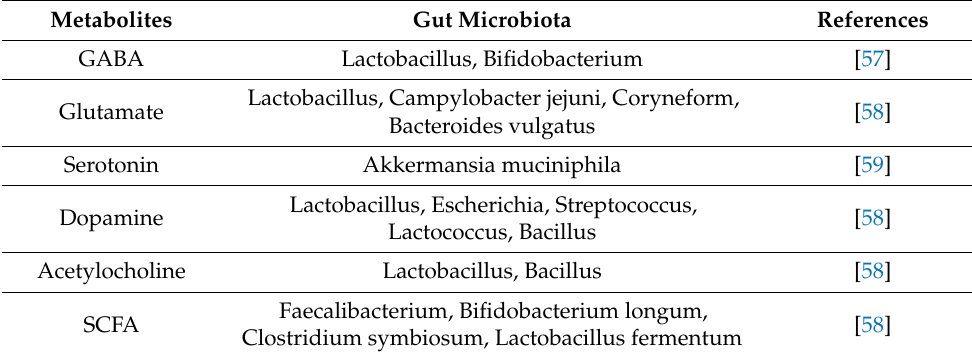
Table 2. Neurotransmitters/metabolites produced by different type of gut microbiota.